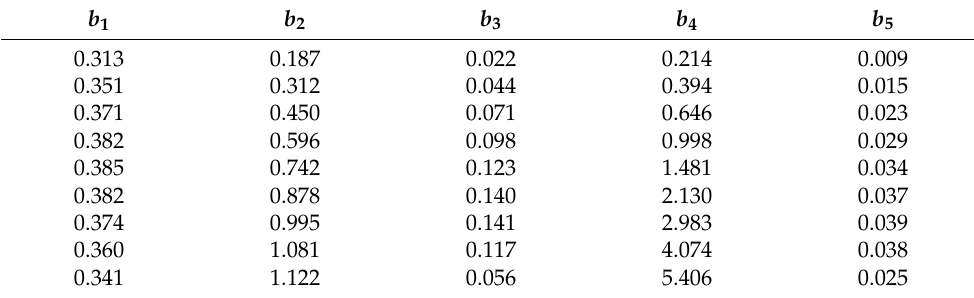
Table 3. Value of b i